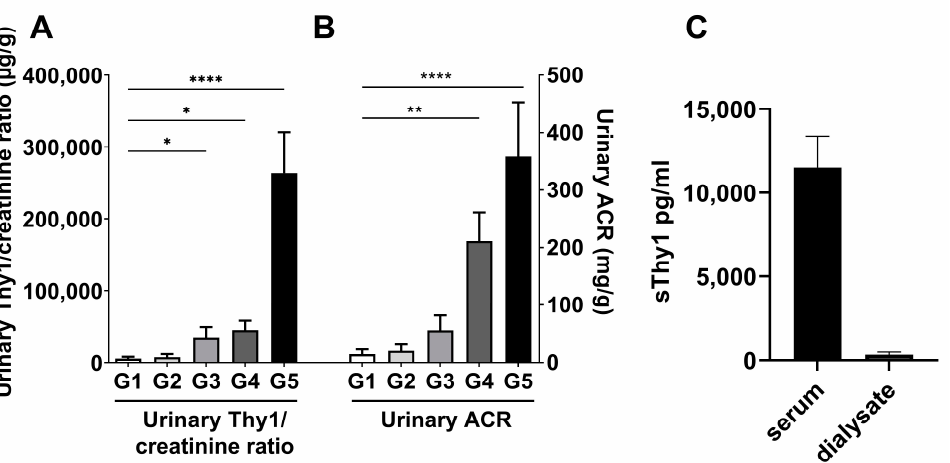
Figure 1. Urinary sThy-1 and dialysate sThy-1 in patients with CKD. Urinary losses of sThy-1 and albumin were detected in spot urine samples of patients with estimated glomerular filtration rate (eGFR) categories G1–G5 (N = 10/eGFR category, all groups G1–G5 were age-, sex- and body mass index-matched). ( A ) Urinary sThy-1/creatinine and ( B ) urinary albumin to creatinine ratio (ACR) were determined in cohort 2 (N = 50). ( C ) The sThy-1 in paired blood and outflow dialysate sampling 10–20 min after start of hemodialysis in patients with kidney failure receiving hemodialysis treatment were analyzed in cohort 3 (N = 6). All results are shown as mean ± standard deviation. One-way ANOVA test in ( A ) and ( B ). *P<0.05; **P <0.01; ****P<0.0001.